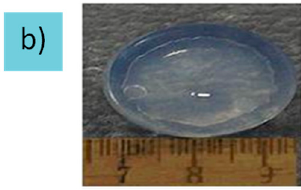
Figure 11. ( a ) Flow scheme for high pressure autoclave system ( b ) Resulting